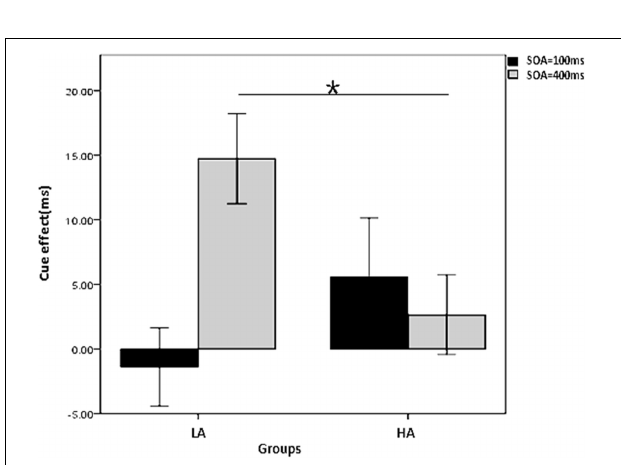
FIGURE 4 | Interaction between group and SOA on the gaze cue effect in the non-predictive condition. *Indicates significant difference between the two